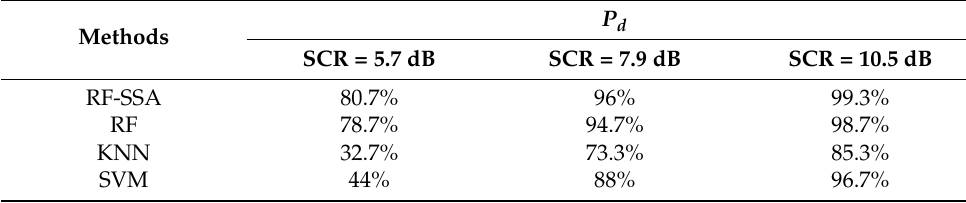
Table 6. Comparisons of the detection